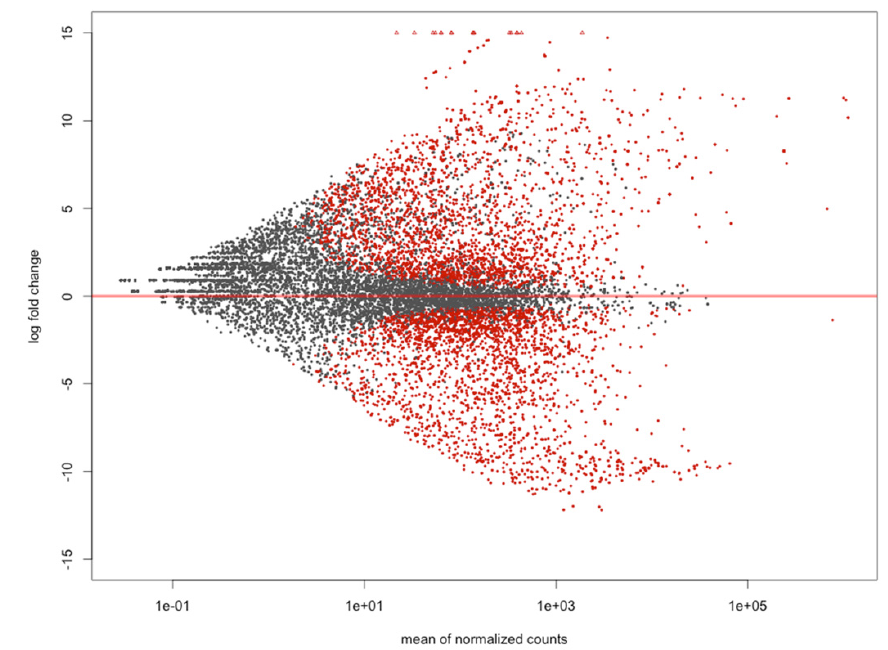
Figure 5. Differentially Expressed Genes (DEGs) from the comparison between unhealthy and healthy conditions after White Spot Syndrome Virus (WSSV) exposure in Litopenaeus vannamei . Significantly DEGs are represented by red dots (False Discovery Rate (FDR) < 0.05) and Log2FC < − 0.5 for healthy and Log2FC > 0.5 for unhealthy animals. Points with negative values are up-regulated genes for healthy shrimps and those with positive values for unhealthy shrimps.